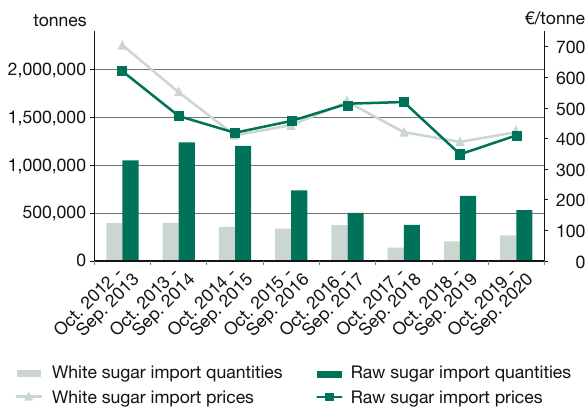
Figure 3 EU28 import quantities and prices of raw and white sugar from African